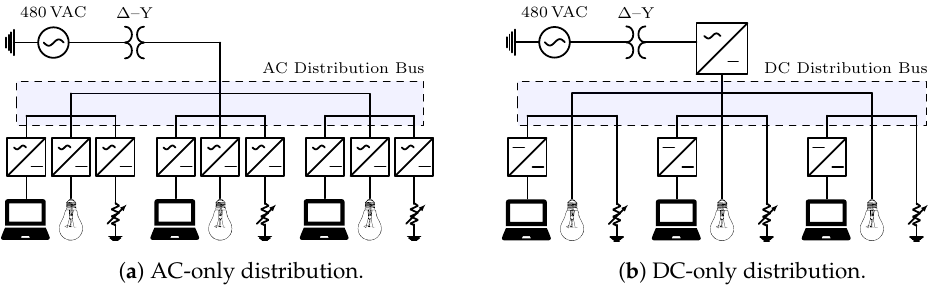
Figure 15. Testbed configurations with AC-only ( a ) and DC-only ( b ).